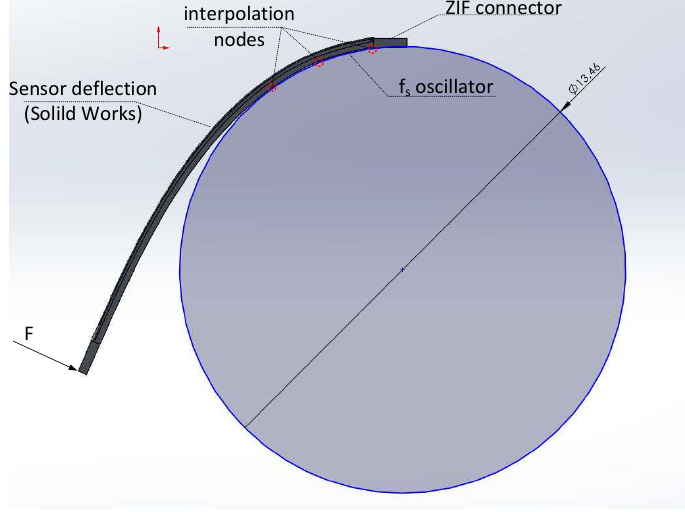
Figure 15. Local sensor deflection approximation near the f s oscillator obtained with finite element